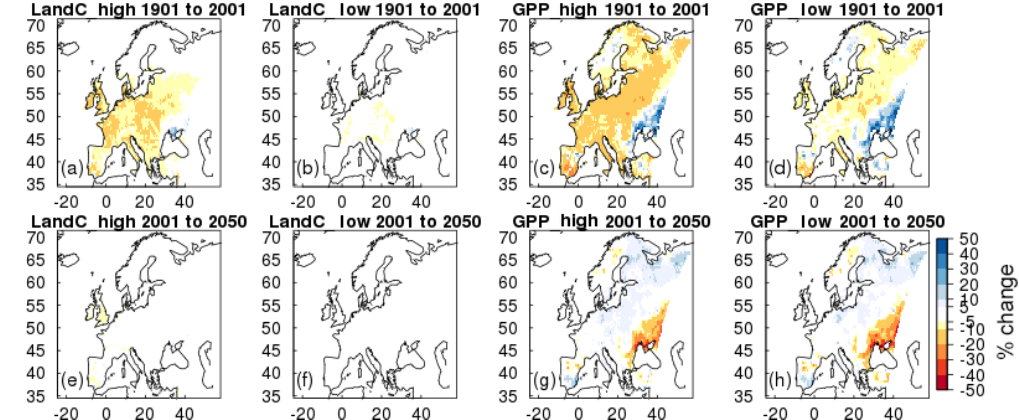
Figure 4. Simulated percentage change in total carbon stocks (Land C) and gross primary productivity (GPP) due to O 3 effects at fixed pre-industrial atmospheric CO 2 concentration (run_O 3 ). Changes are shown for the periods 1901 to 2001 and 2001 to 2050 for the high and low plant O 3 sensitivities.